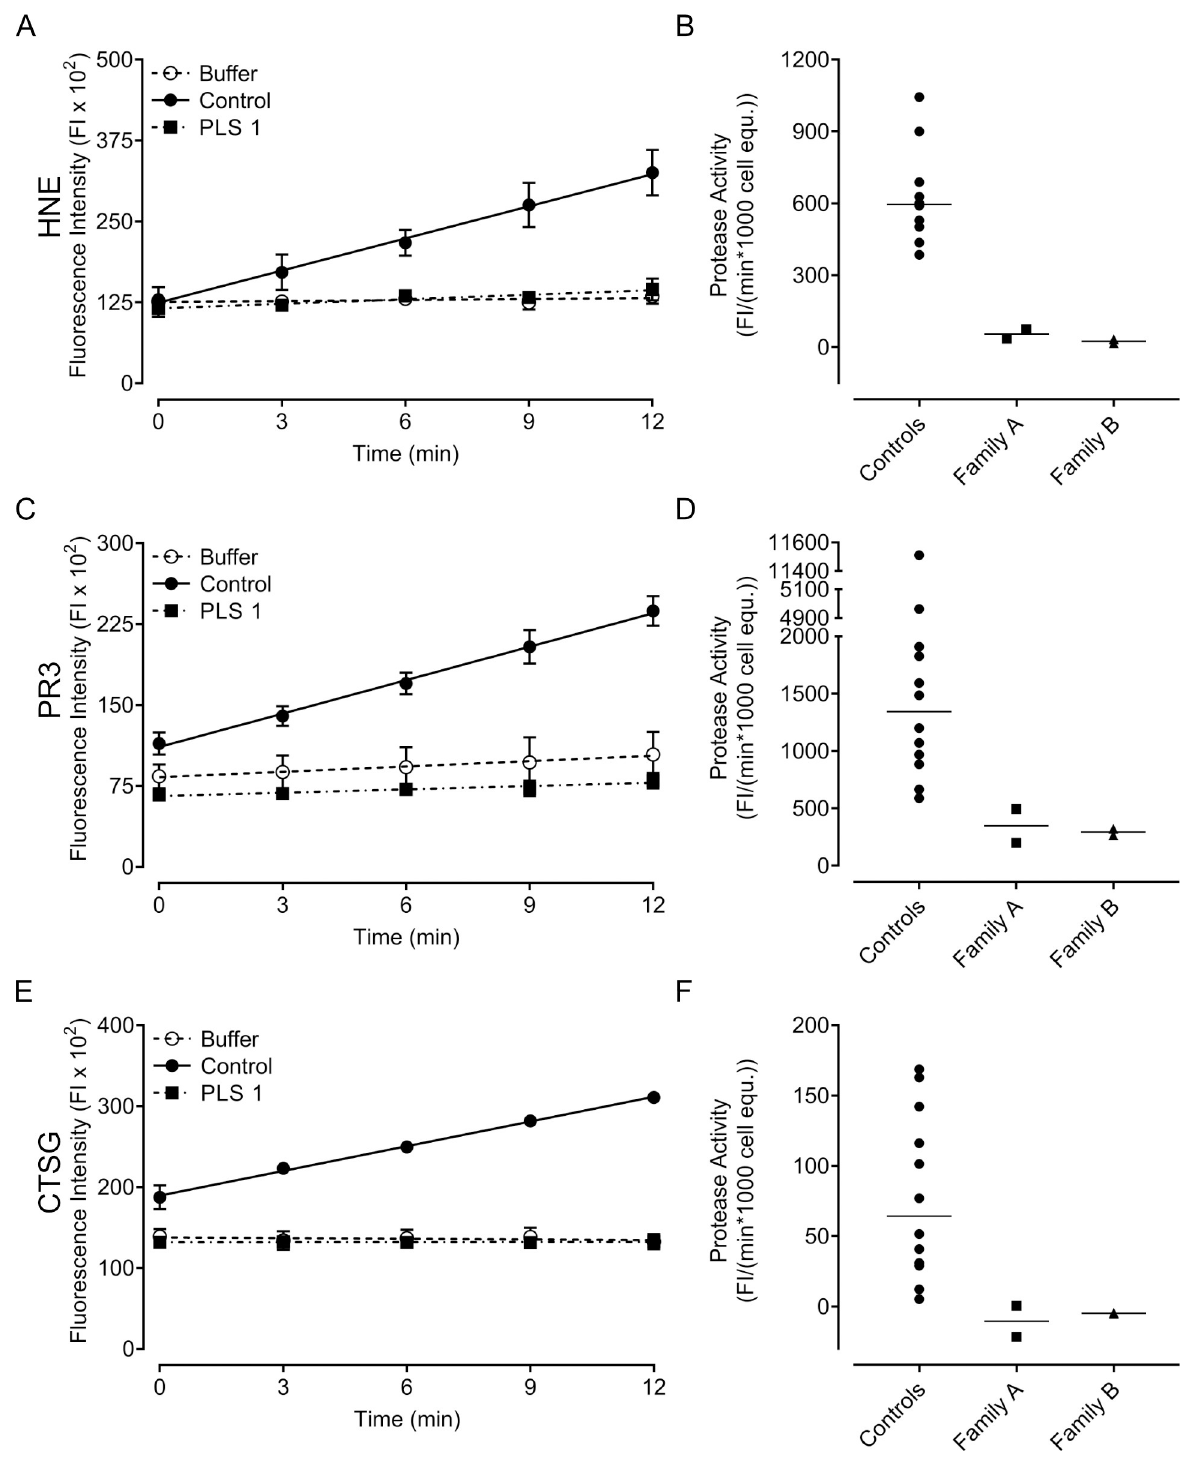
Fig 4. Fluorescence-based protease activity assay for NSP activity of neutrophil lysates. (A, C, E) Representative results of HNE, PR3 and CTSG activity assays, respectively, with neutrophils lysates (in triplicate) of one healthy control, PLS 1, and lysate-free buffer control. Symbols are means ± standard deviation and lines represent the linear regressions of the fluorescence measurement on the linear section of the kinetic graphs (0–12 min). (B, D, F) Protease activities of neutrophils from patients with PLS (family A, n = 2 and B, n = 2) and healthy controls (n = 12) resulting from the linear regression of the fluorescence measurement (0–12 min). Each symbol represents mean per individual (of three technical repeats) and the horizontal line represents the mean of all samples from the indicated groups. https://doi.org/10.1371/journal.pone.0261724.g004 PLOS ONE | https://doi.org/10.1371/journal.pone.0261724 December21,